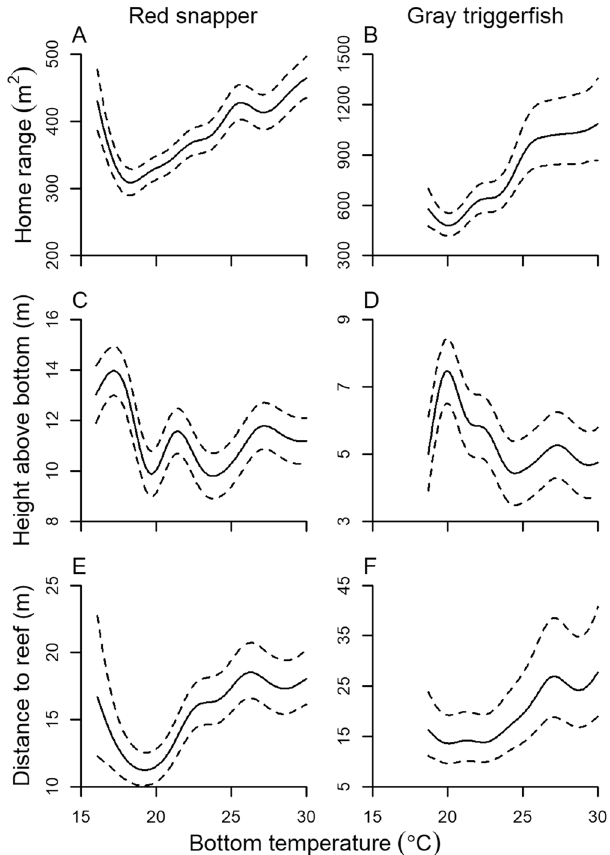
Figure 6. GAMM predicted (solid line) and 95% CIs (broken line) of hourly home range (95% KDE; A , B ), height above bottom ( C , D ), and distance to reef ( E , F ) of red snapper and gray triggerfish as a function of bottom water